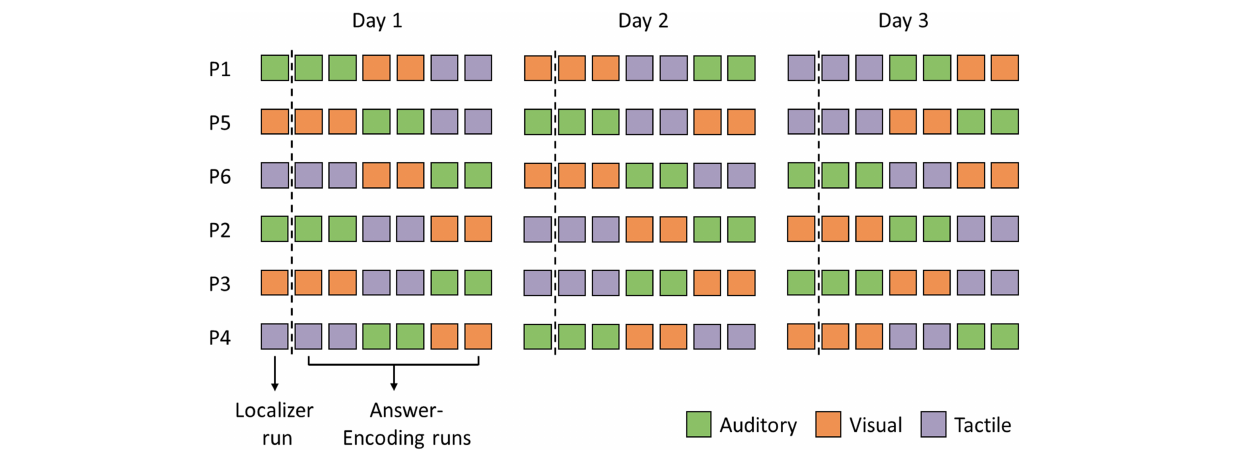
rest periods (20 s), participants were instructed not to